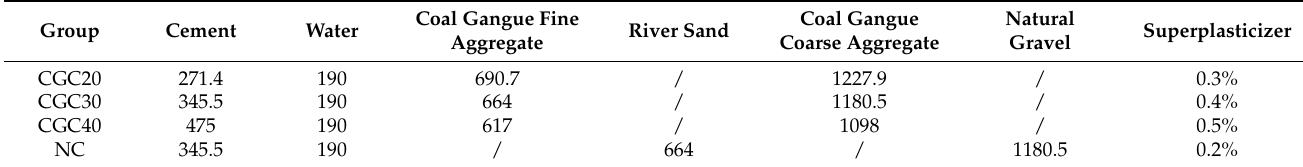
Table 4. Mix proportion of concrete (kg/m 3